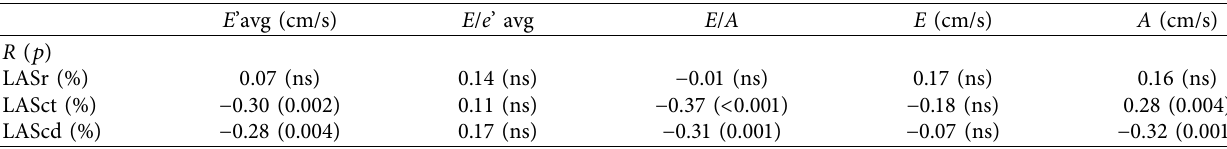
Table 4: Correlation of LAS values with LV diastolic function